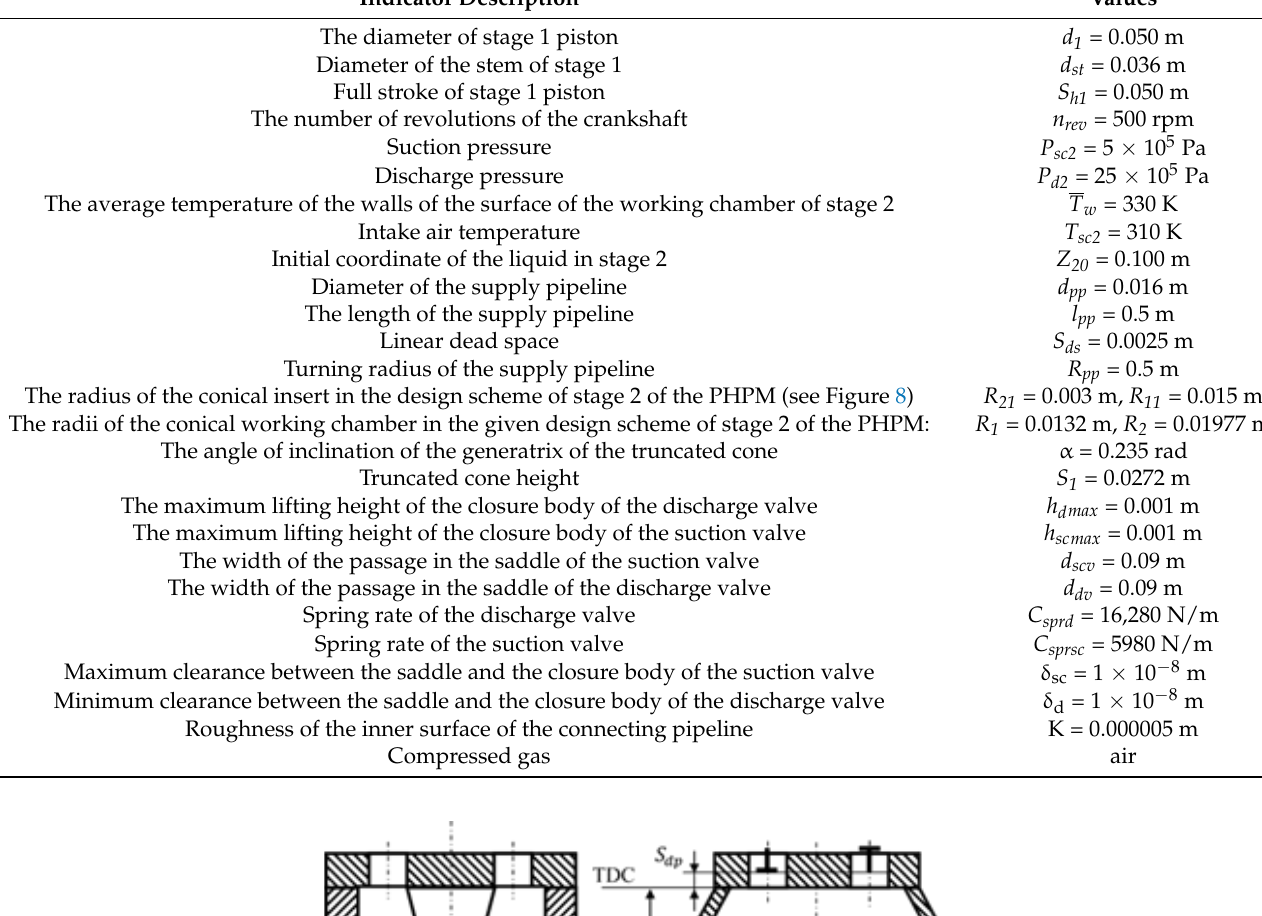
Table 3. Main geometrical and operational parameters of two-stage PHPM.